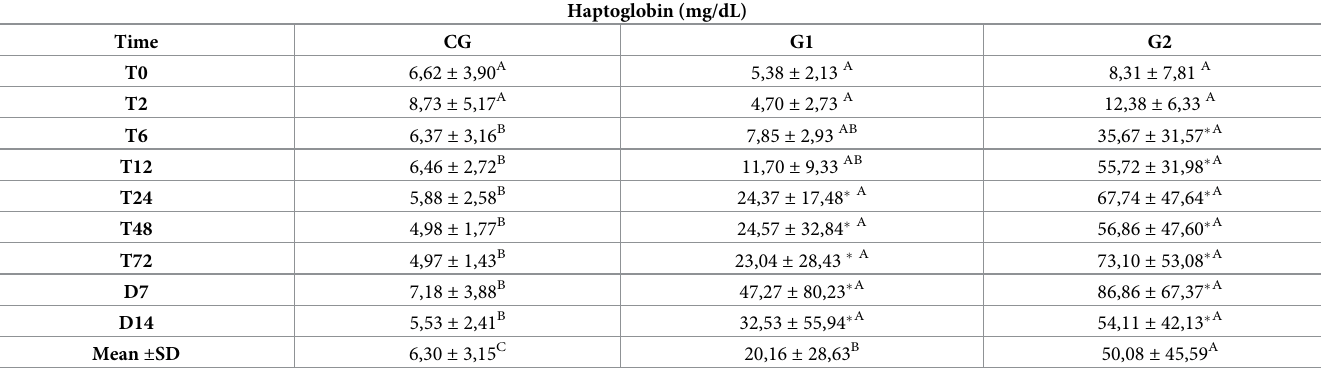
Table 13. Mean and standard deviation (SD) of haptoglobin in the peritoneal fluid of healthy horses (CG) and horses submitted to cecal trocarization with a cecal needle (G1) or a cattle trocar (G2).